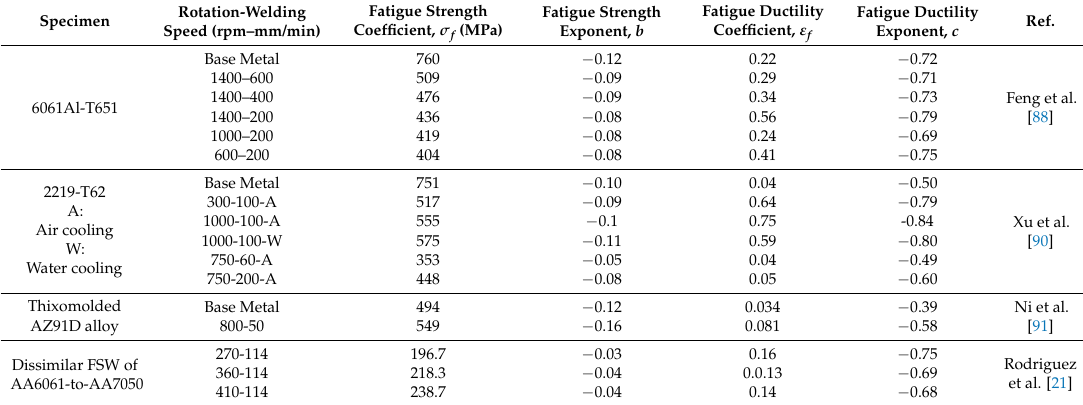
Table 2. Low cycle fatigue parameters for different aluminum